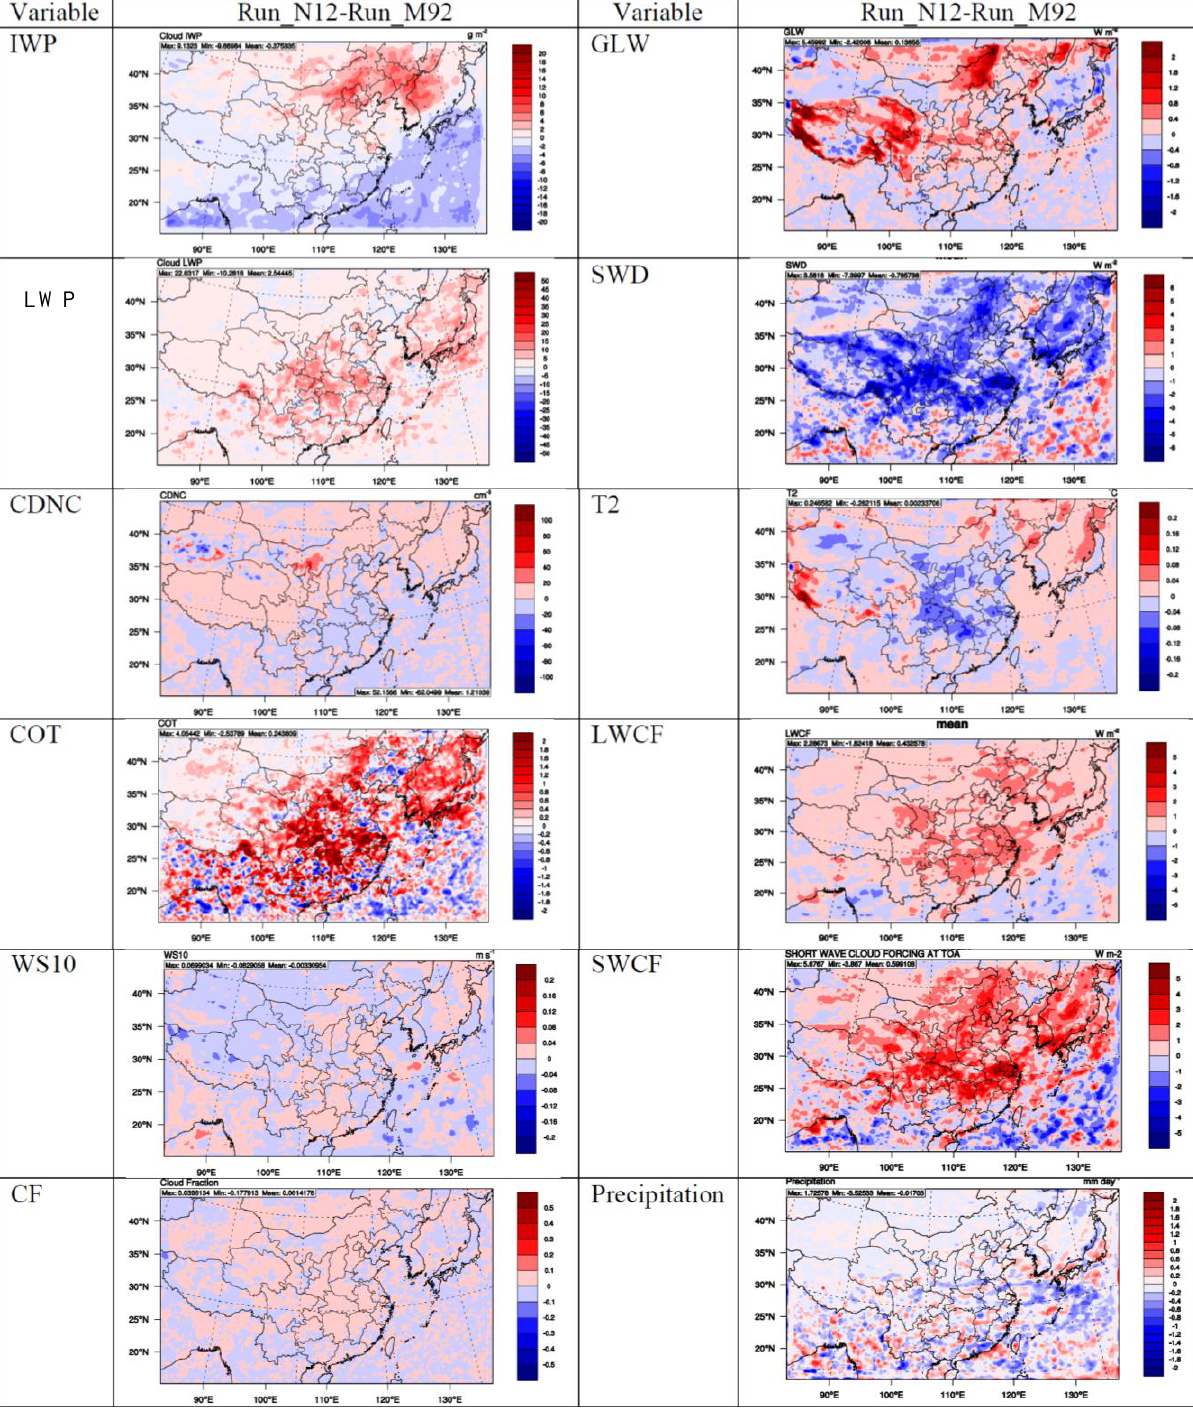
Figure 6. Spatial distributions of absolute differences of IWP, LWP, CDNC, COT, WS10, CF, GLW, SWD, T2, LWCF, SWCF, and precipitation between Run_N12 and Run_M92 for